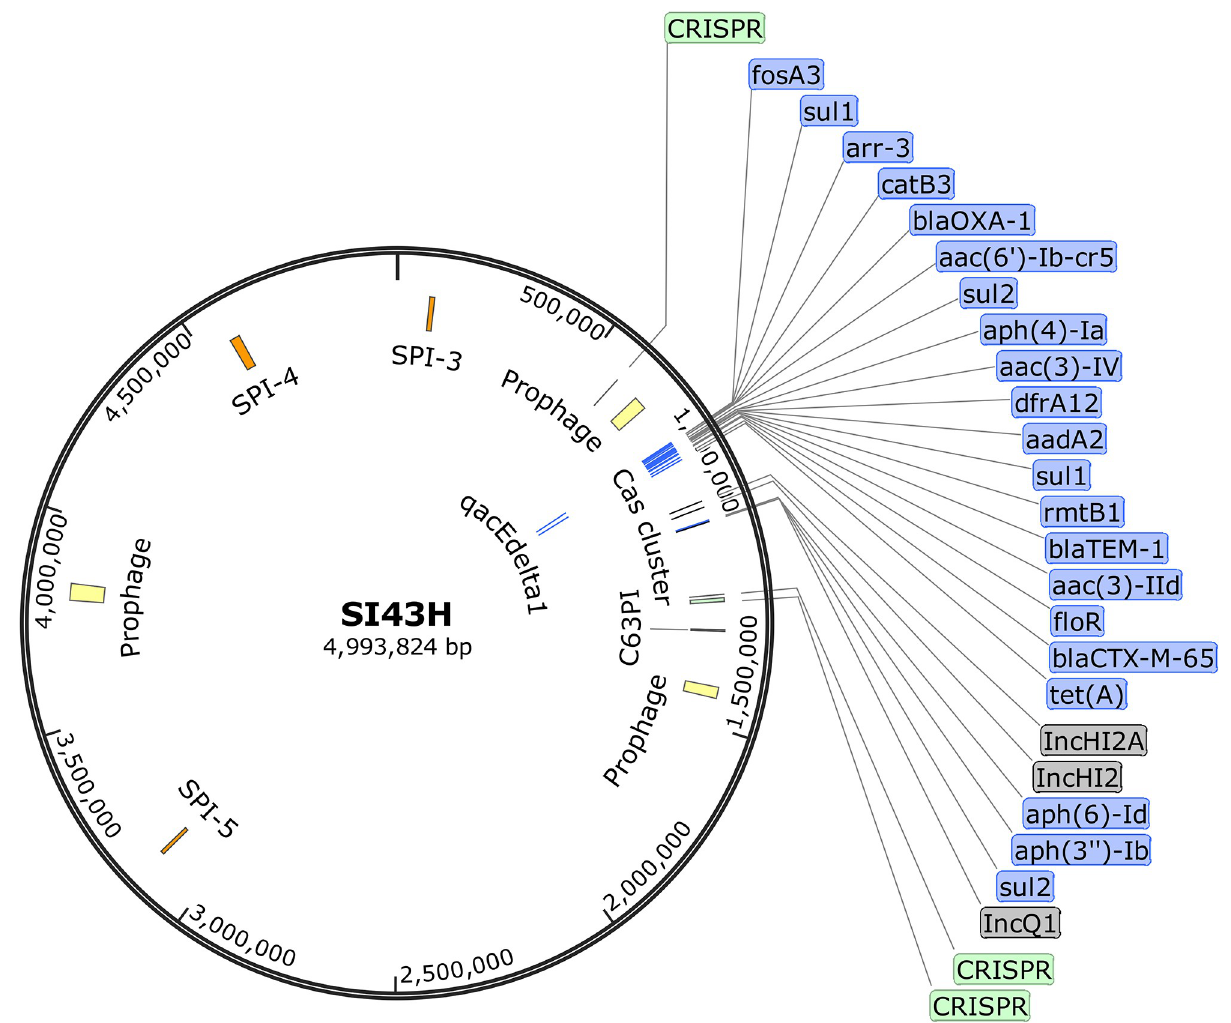
Fig 2. Circular chromosome map of S . Indiana isolate 43 (SI43H) based on its hybrid assembly.